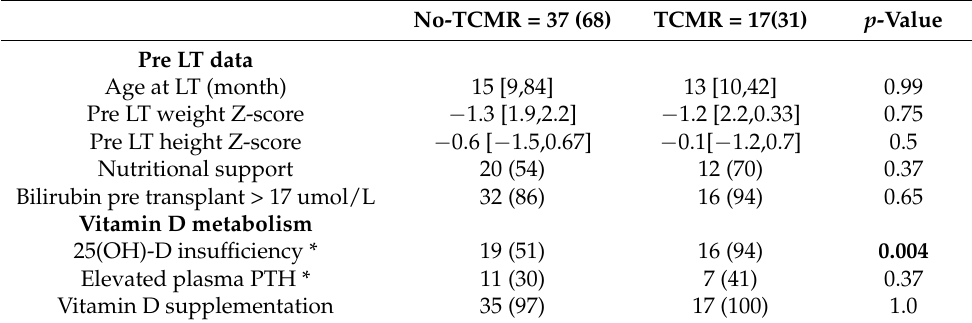
Table 3. TCMR in patients with cholestatic disease N =